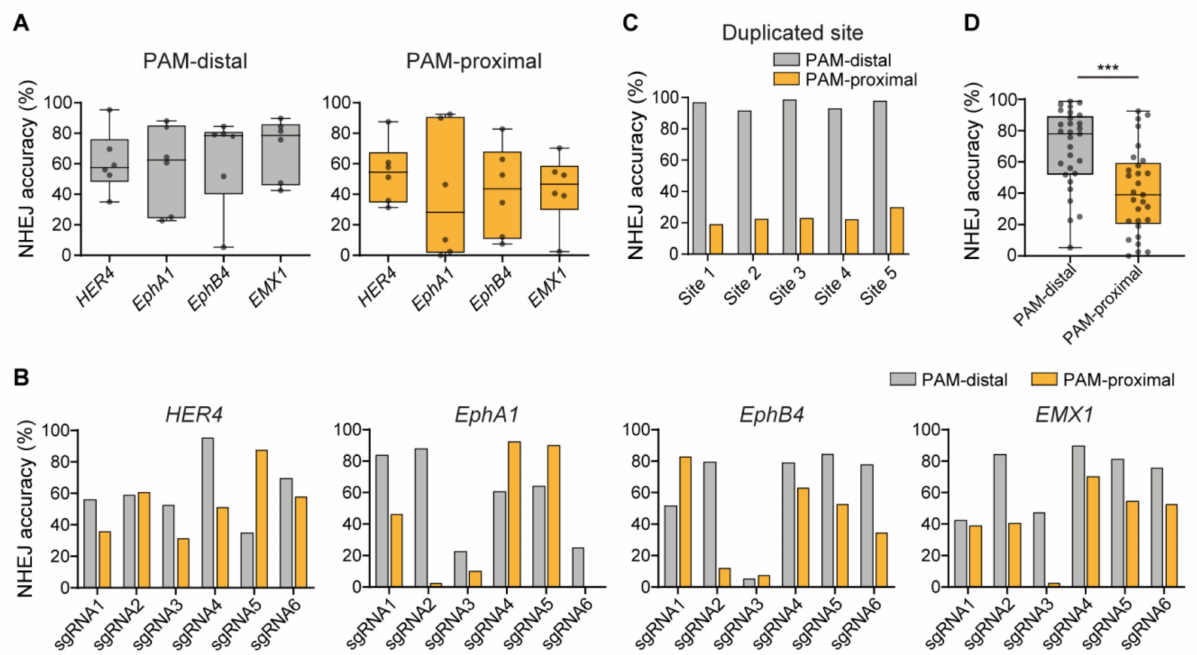
Figure 2. Sequence dependency of NHEJ accuracy in HeLa cells. ( A ) Comparison of NHEJ accuracy among the four genes (PAM-distal, p = 0.8732, Kruskal–Wallis test; PAM-proximal, F(3,20) = 0.2545, p = 0.8572, one-way ANOVA) (plot line: median, box: 25–75% percentiles, error bars: range). ( B ) NHEJ accuracy at each targeted site. ( C ) NHEJ accuracy at the sites having the same sequence. ( D ) Comparison of NHEJ accuracy between the PAM-distal end and the PAM-proximal end (*** p = 0.0007, Wilcoxon signed rank test) (plot line: median, box: 25–75% percentiles, error bars: